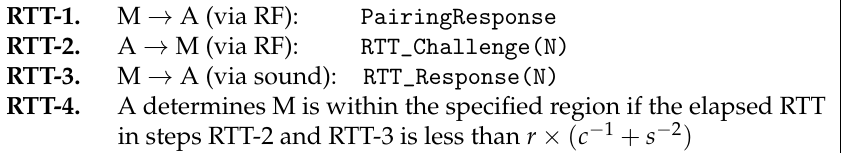
Figure 4. RTT-based distance verification